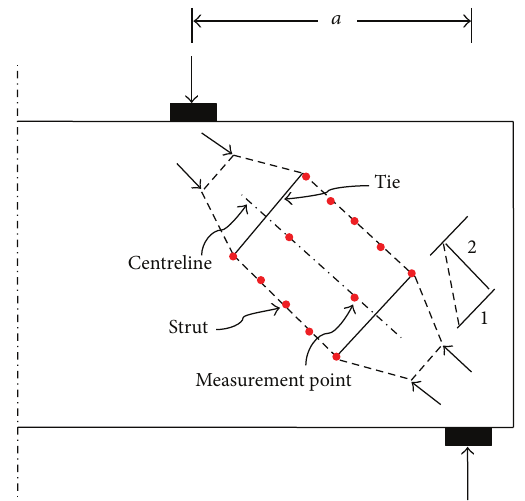
Figure 1: Strut-and-tie model of a bottle-shaped strut including measurement